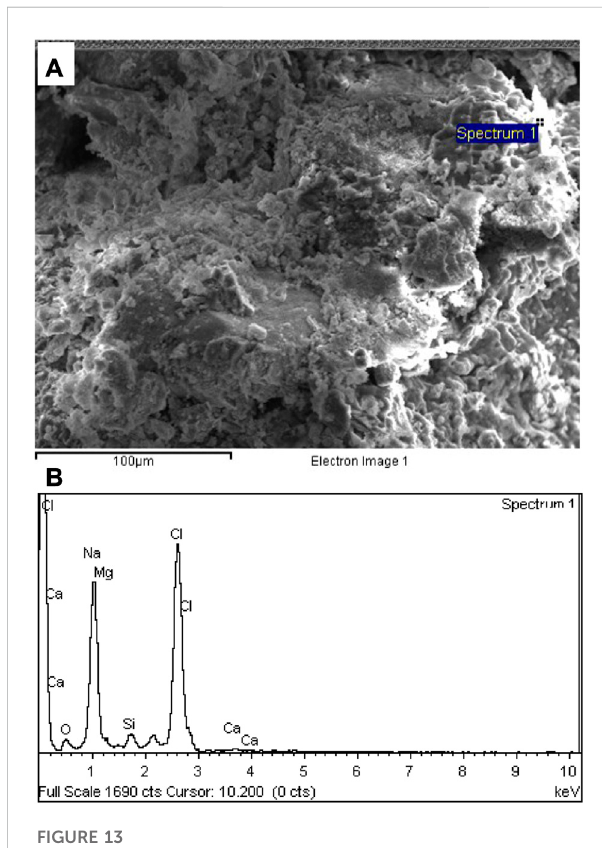
FIGURE 13 (A) SEM and (B) EDX of soil with 20% NaCl.